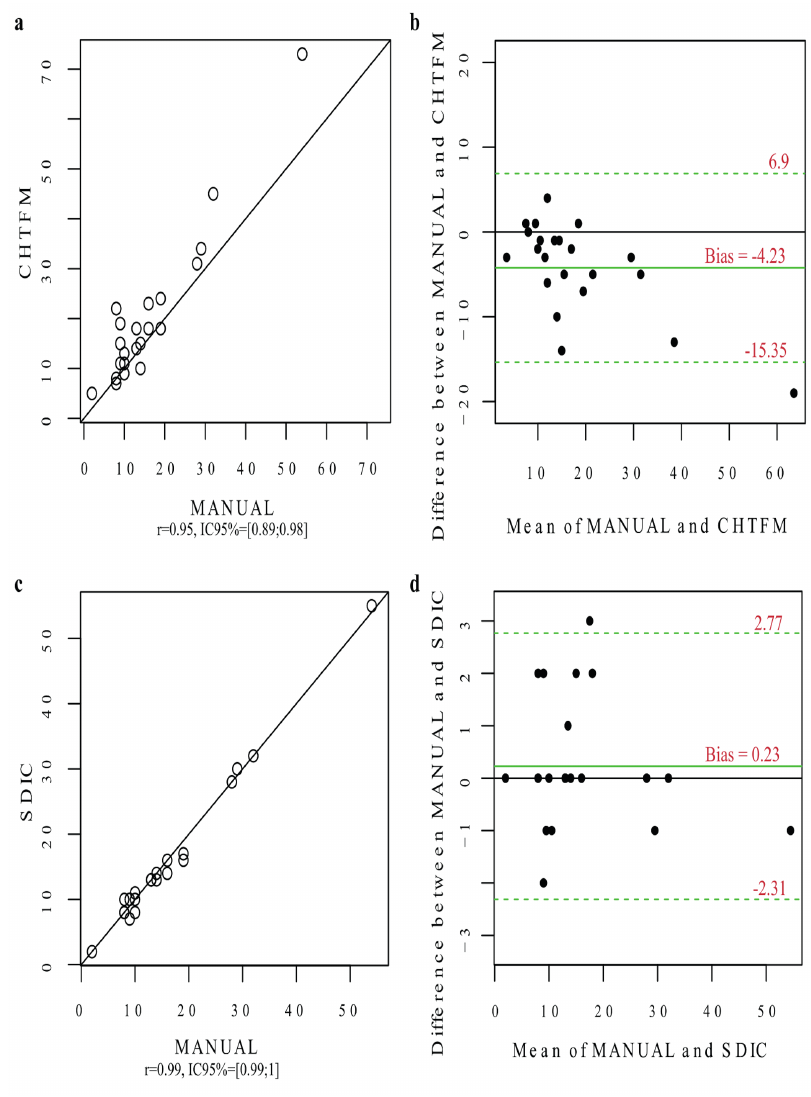
Figure 4 - Correlation graph between the Manual method and the CHTFM method (a) ; Bland-Altman graph between the Manual method and the CHTFM method (b) ; Correlation graph between the Manual method and the SDIC method (c) ; Bland-Altman graph between the Manual method and the SDIC method (d) .